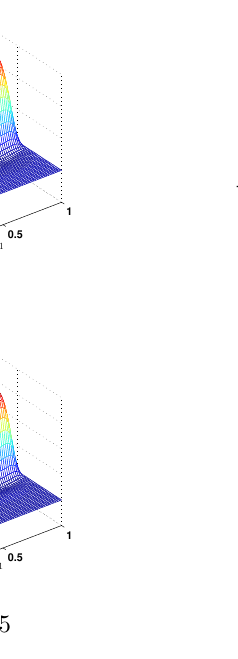
Figure 3. Problem 1: Surface plots of the state obtained by different timesteps on a 64 × 64 grid and β = 10 − 6